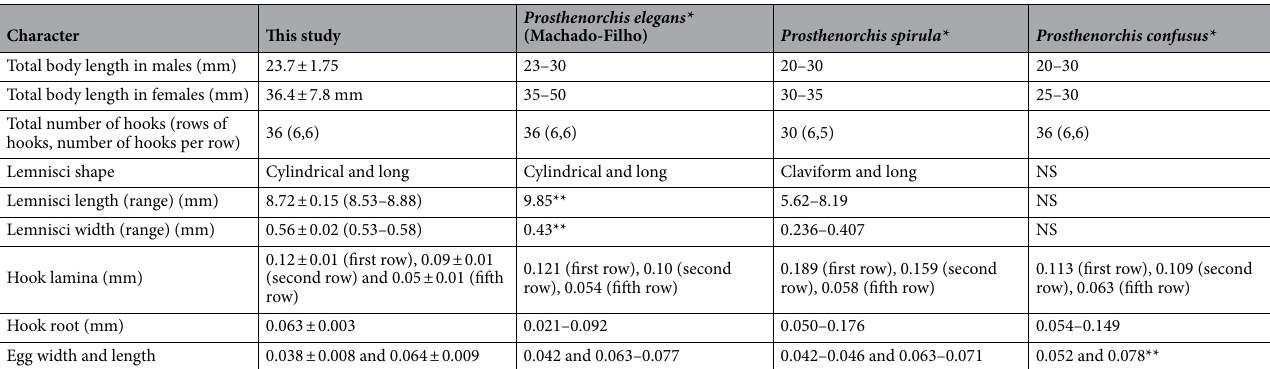
Table 1. Morphological measurements of P. elegans collected herein compared to the original species description made by Machado-Filho and other Prosthenorchis spp. Measurements provided for the specimens of this study correspond to the average with standard deviation. NS, not specified. *The number of individuals for taking each measurement is not specified. **Not specified if number is an average, minimum, or maximum